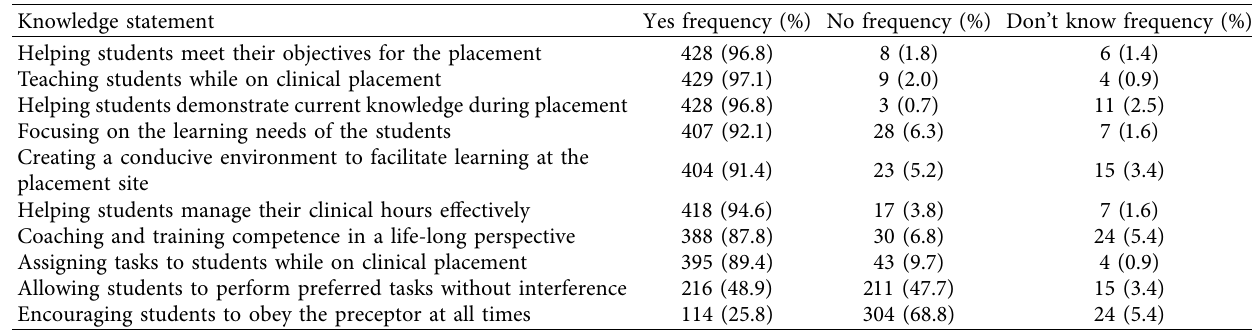
Table 1: Descriptives on the knowledge of nurses and midwives on preceptorship ( N � 442).